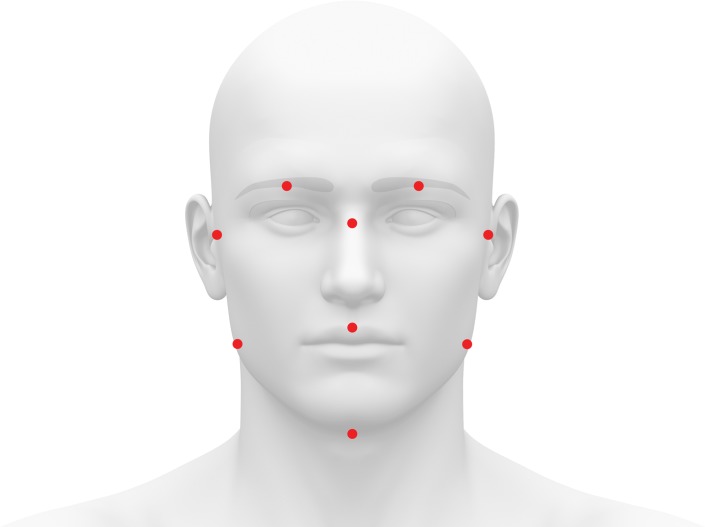
Facial landmarks used to derive facial masculinity ratios.